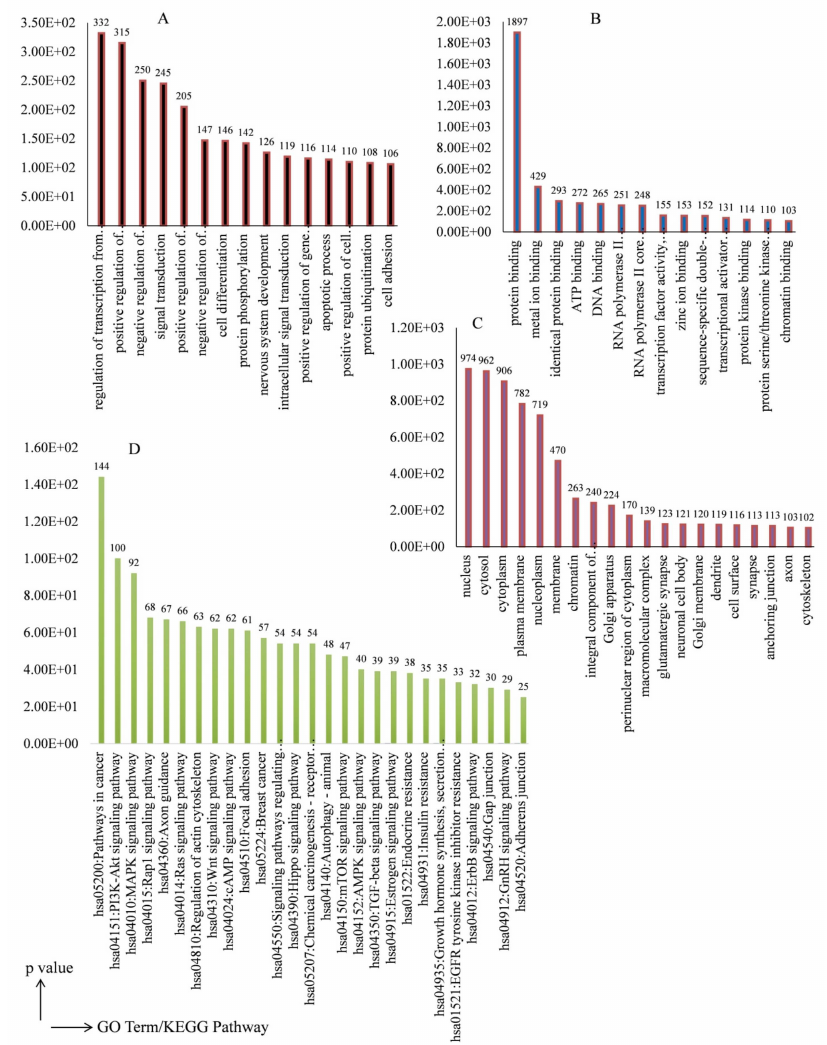
Figure 2. Gene ontology and KEGG pathway analysis of target genes of differentially expressed miRNAs in Withaferin-A-treated MDA-MB-231 cells. Differentially expressed miRNAs target gene enrichment in different GO terms ( A ) Biological process ( B ) Molecular function, and ( C ) Cellular component. The respective events of different GO terms were selected on the basis of significance value ( p < 0.0001) and count number ≥ 100. Significant values of the events are mentioned above the respective term bar. ( D ) The significant ( p < 0.0001) target genes of the differentially expressed miRNAs in MDA-MB-231 cells enriched in different KEGG pathways. Fold enrichment (gene count) values are shown above the respective pathway